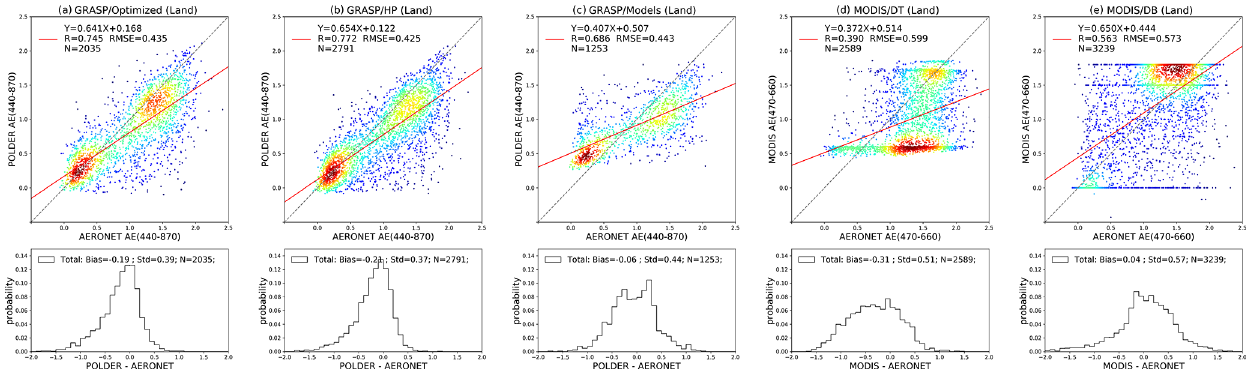
Figure 11. Validation of PARASOL/GRASP ( a GRASP/Optimized, b GRASP/HP and c GRASP/Models) and MODIS ( d DT and e DB) AE over land in 2008. The gray dashed line and the red solid line are the 1 : 1 reference line and the linear regression line. The probability density functions of differences (satellite–AERONET) are present in the lower panels.